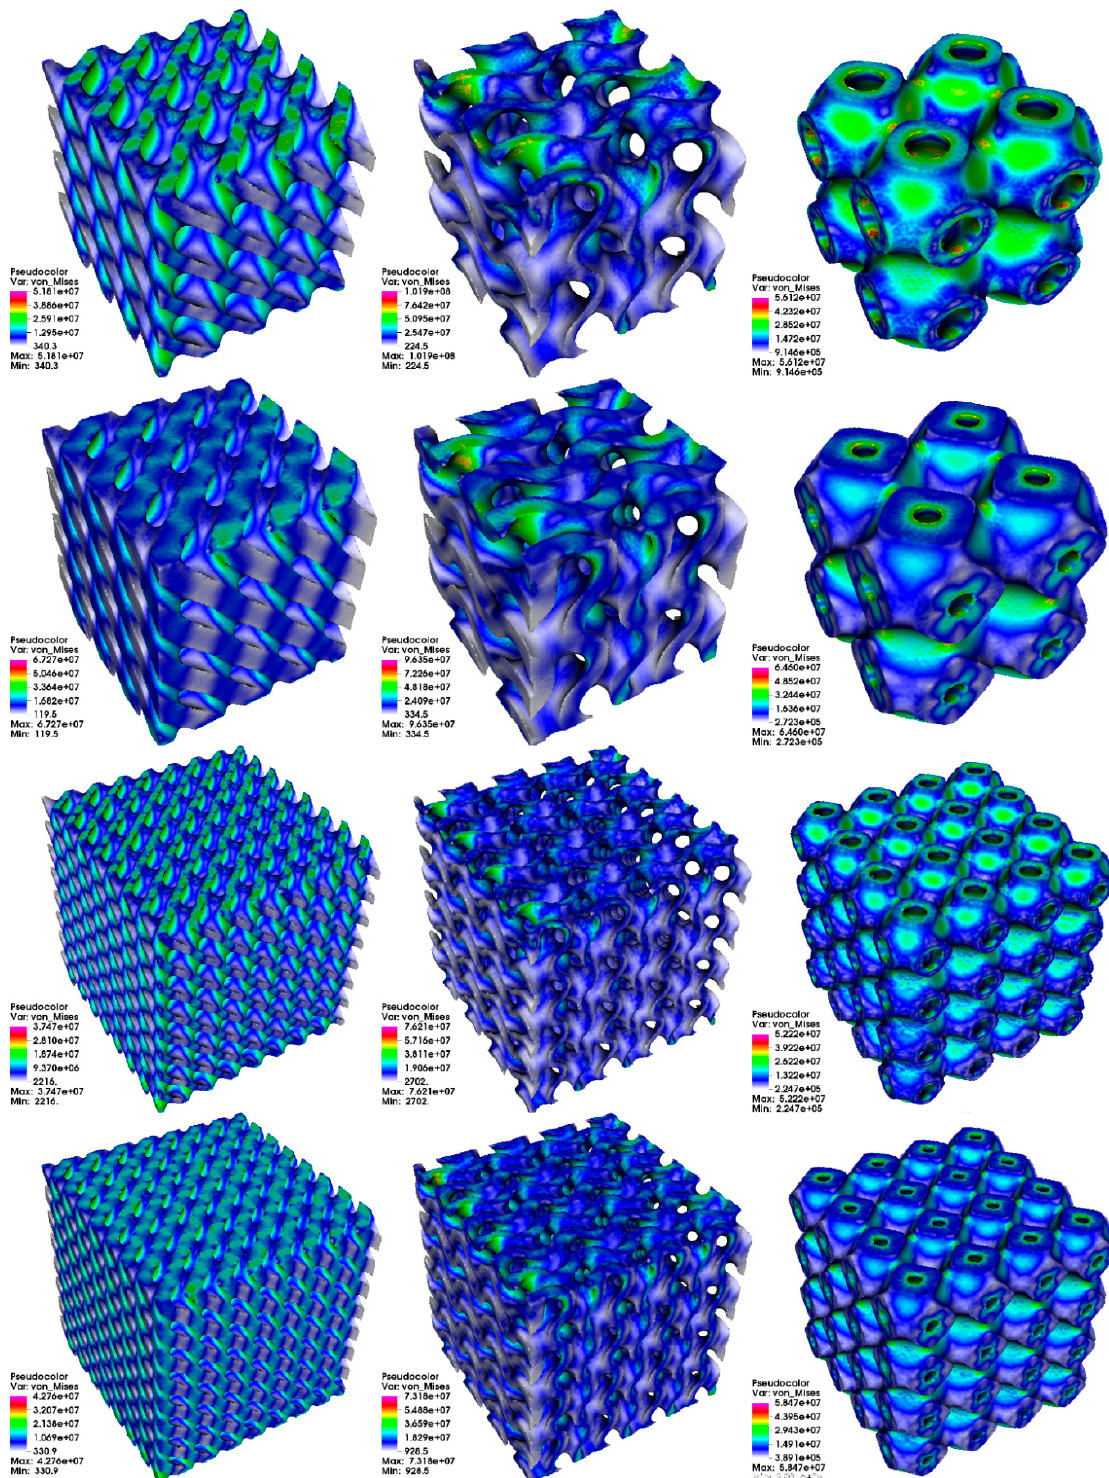
Figure 4. Von Mises stress distribution in MPa. Columns from left to right: diamond (D) surface, gyroid (G) surface, primitive (P) surface. Rows from top to bottom: 2 cells, relative thickness δ = 0.125; 2 cells, relative thickness δ = 0.2; 4 cells, relative thickness δ = 0.125; 4 cells, relative thickness δ = 0.2.